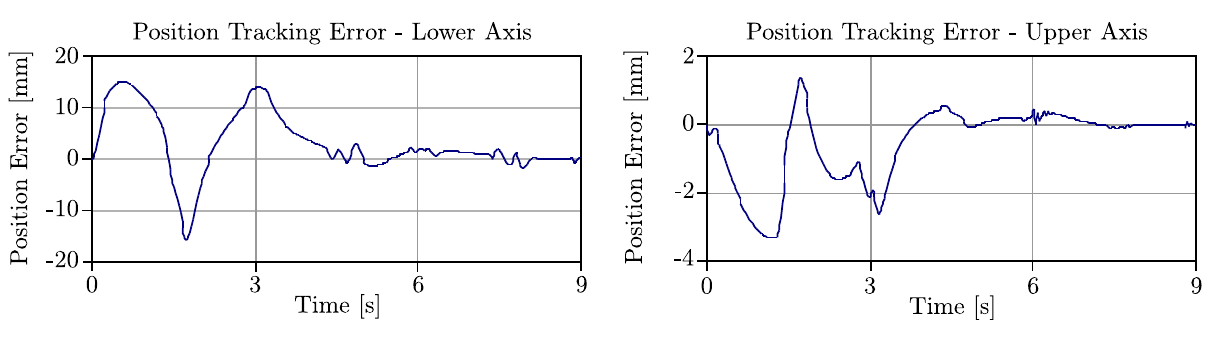
Figure 5: Tracking error - lower axis